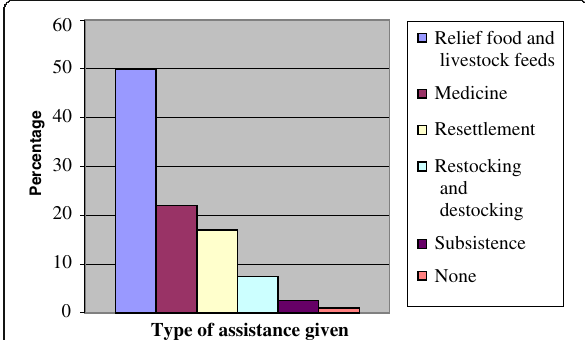
Figure 3 Type of assistance given by the Government and other